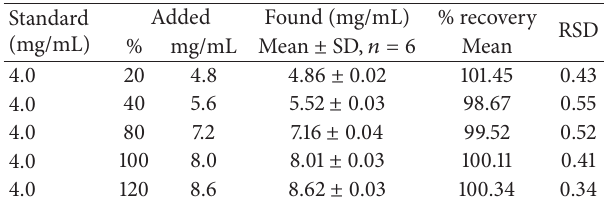
Table 3: Accuracy of the method.